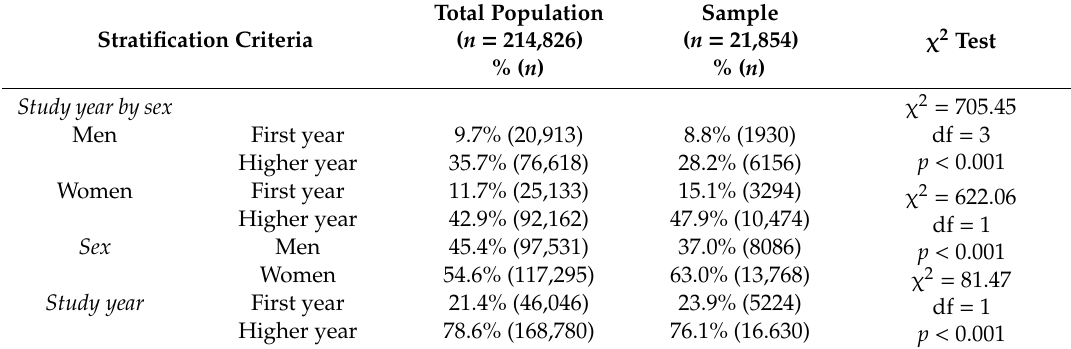
Table 1. Chi-square di ff erence tests between the Flemish higher education population in the academic year, 2016–2017 (born between 1992 and 1999), and survey data of students aged 17 to 24 years, stratified by sex and study year